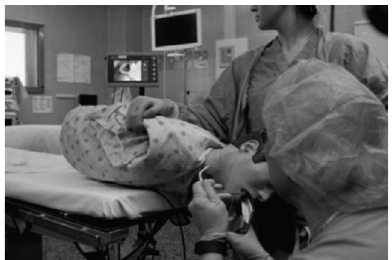
Figure 5: Image depicted is a near representation of the technique used on the second attempt to intubate the patient